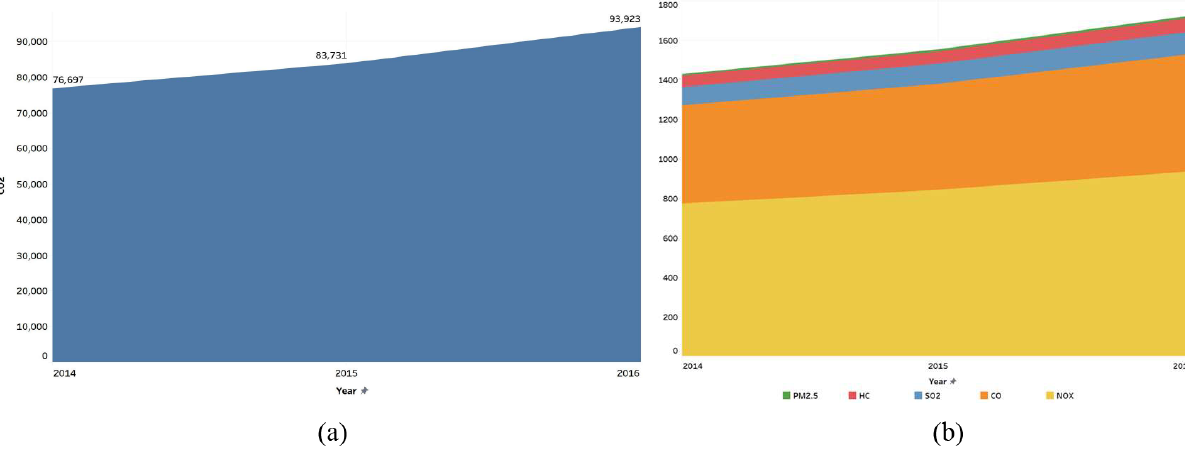
Figure 7. Annual average emissions of six pollutants from routes before the CNG2020 strategy was proposed (tonnes). (a) Average overall route emissions of CO 2 from 2014 to 2016. (b) Average overall route emissions of the other five pollutants from 2014 to